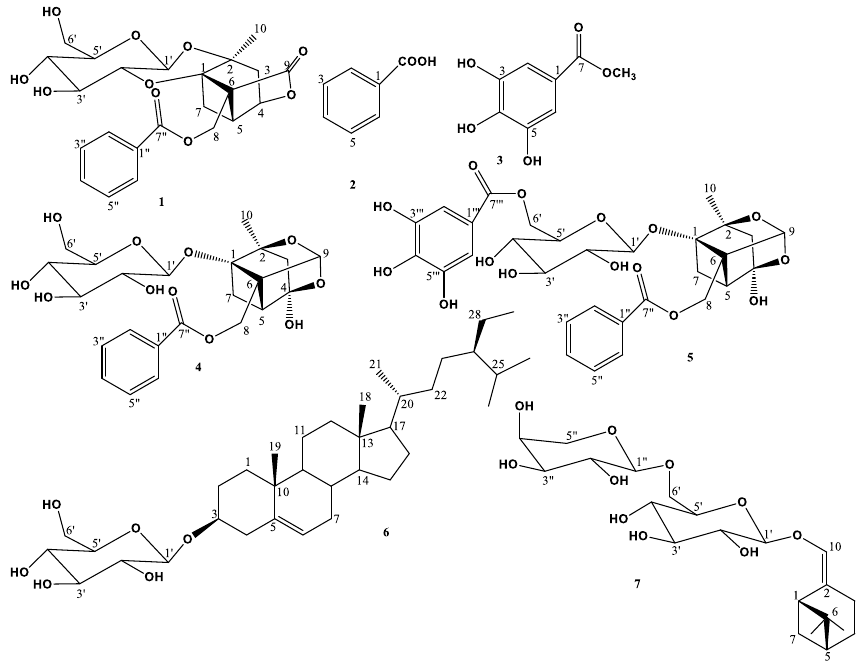
Figure 1. Structures of the isolated compounds of P. officinalis